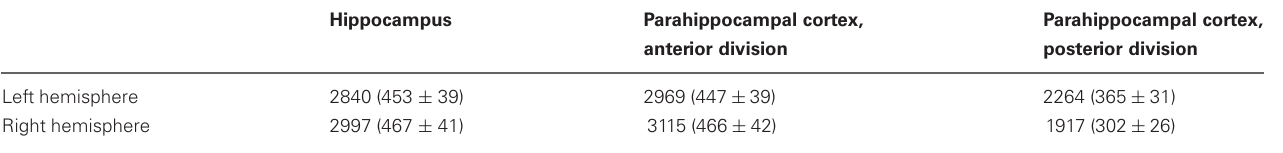
Table 1 | Number of 2-mm isotropic voxels inside the Regions-of-Interest of the medial temporal lobes as defined in Harvard–Oxford cortical atlas; brackets show the mean number of 3-mm isotropic voxels ( ± standard deviation) after transformation in the subject-native EPI